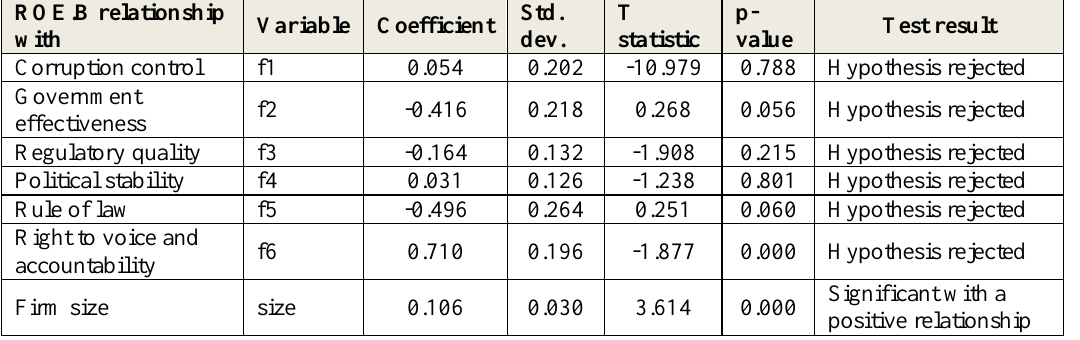
Table 8. ROE.B relationship with governance indicators